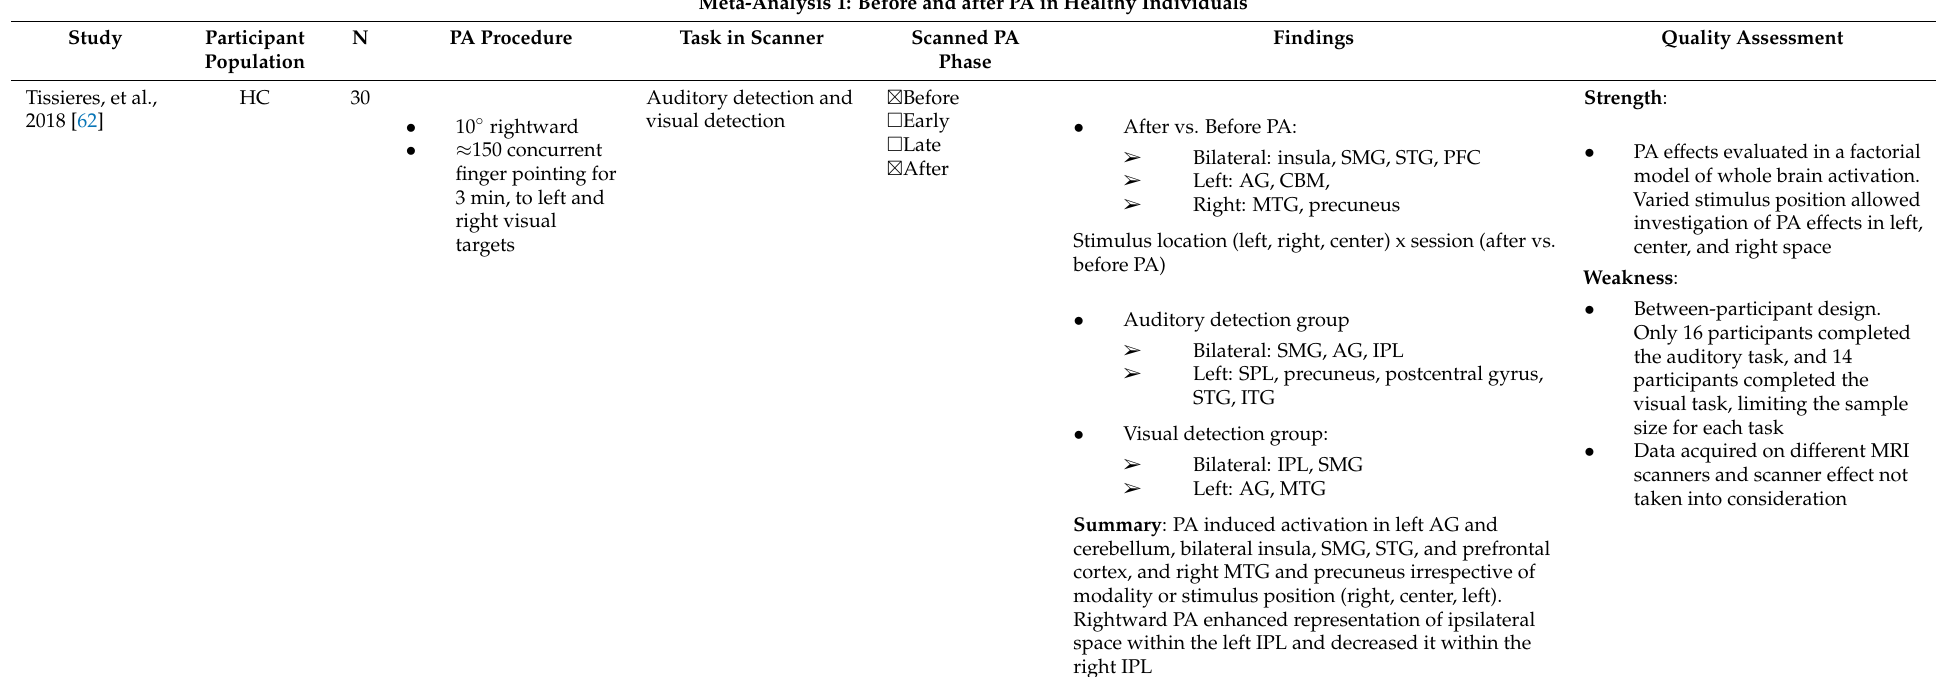
Meta-Analysis 1: Before and after PA in Healthy